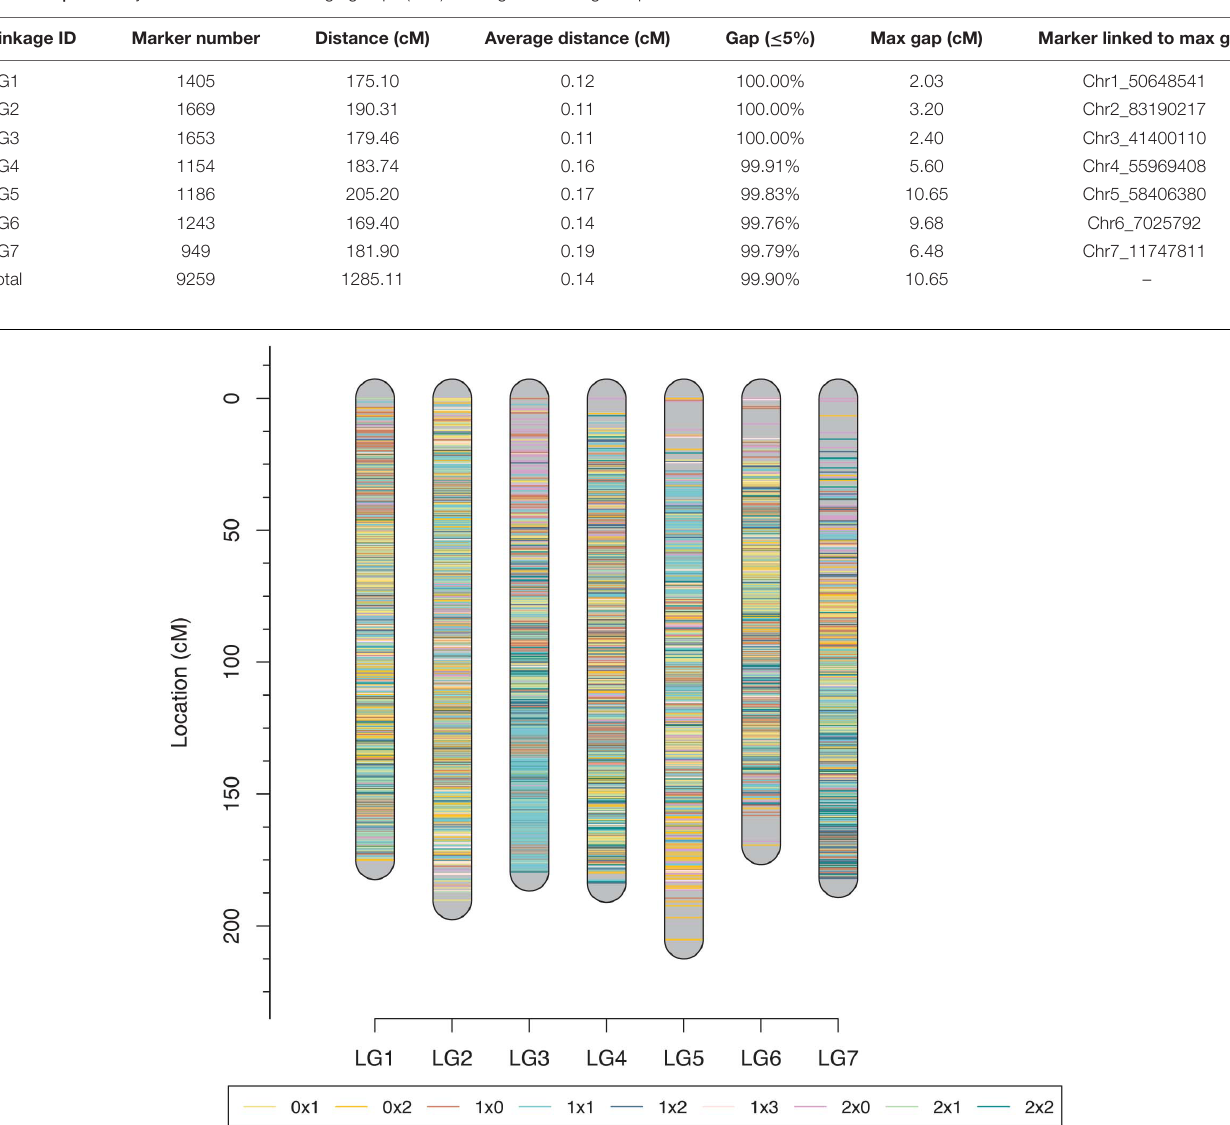
a minimum average distance of 0.11 cM. LG7 was the